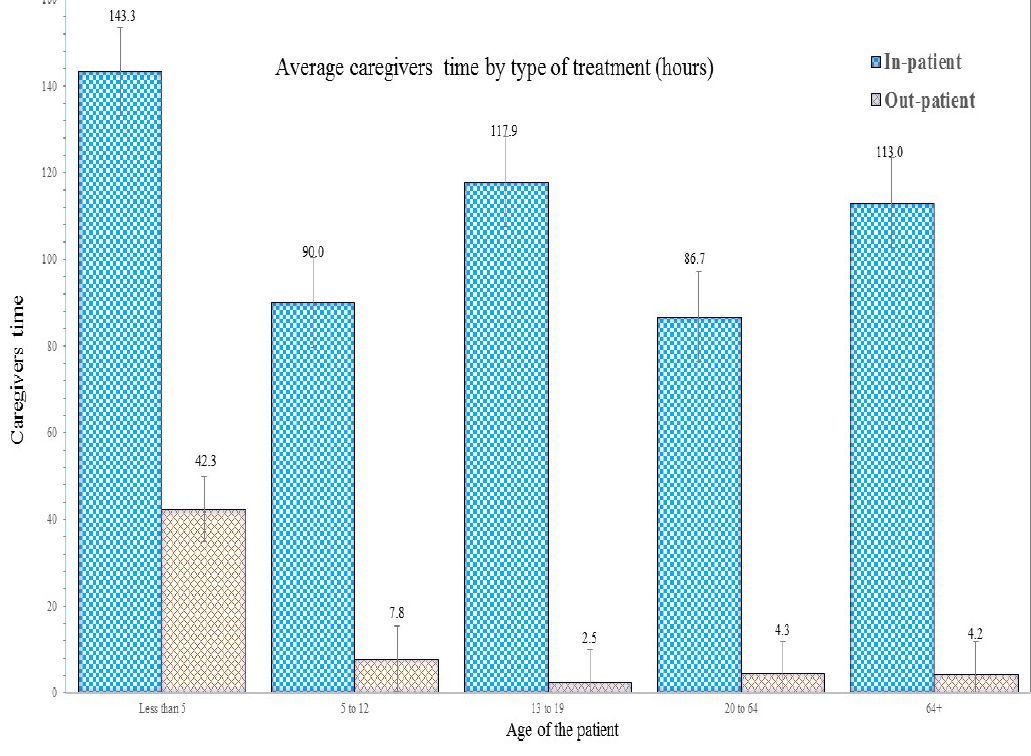
Figure 1. Average caregivers’ time by type of treatment (h).